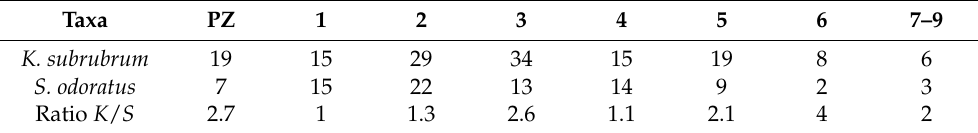
Table 9. Distribution comparison of mud and musk